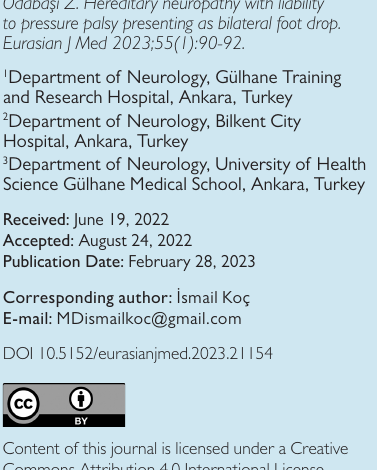
Figure 1. Conduction blocks were detected between the proximal and distal parts of the elbow in the right ulnar nerve (arrow).